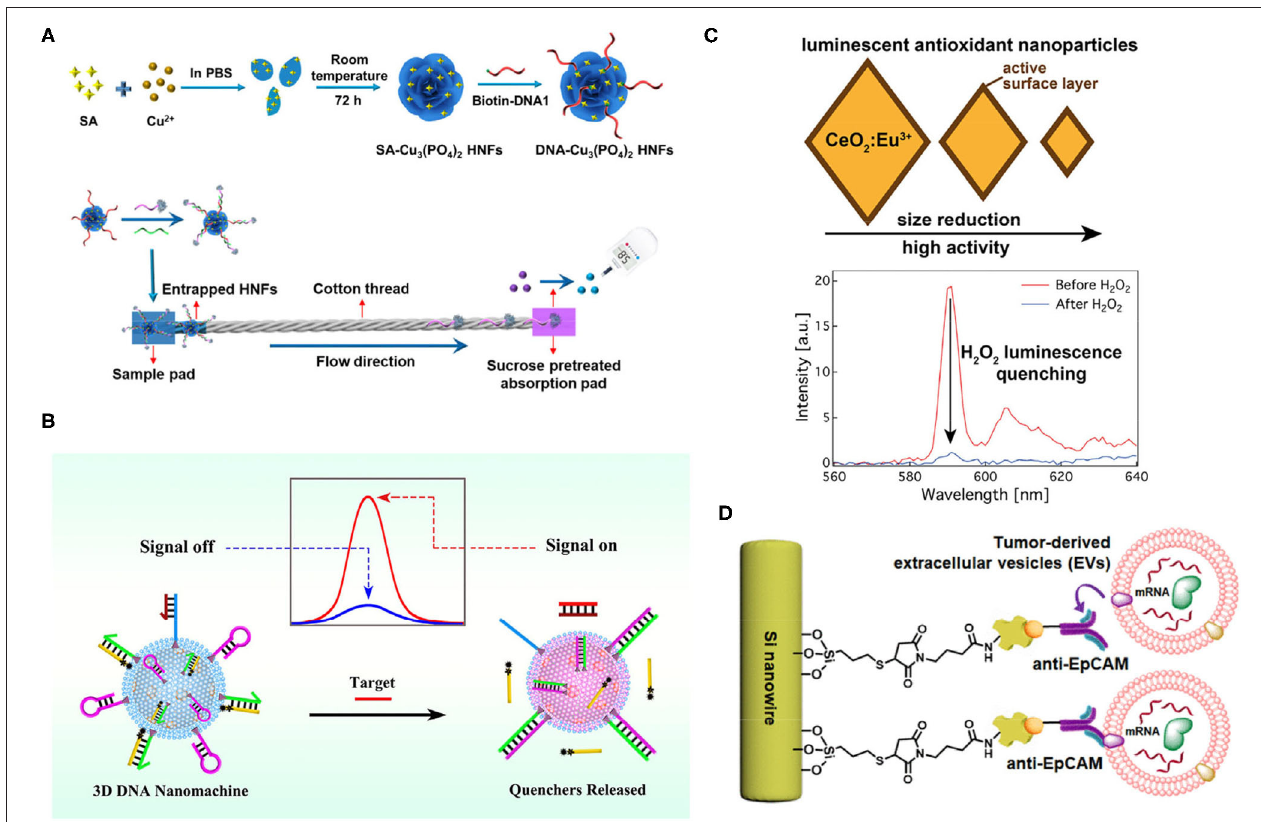
FIGURE 3 | (A) A schematic of the formation of DNA–Cu 3 (PO 4 ) 2 hybrid nanoflowers (HNFs)s and their detection of target microRNAs (miRNAs). Target miR-21 conjugates with HNFs and trapped on the cotton thread; free DNA2-invertase conjugates hydrolyze sucrose into glucose, and the signal was readout by personal glucose meter (PGM) (Wu et al., 2018). (B) A schematic of the signal on and off when detecting miRNA, using 3D Nanomachine. Targets were recognized by nanomachine, which released quenchers, and the fluorescent signal was detected ( Peng et al., 2019). (C) The smaller size of CeO 2 :Eu 3 + demonstrated